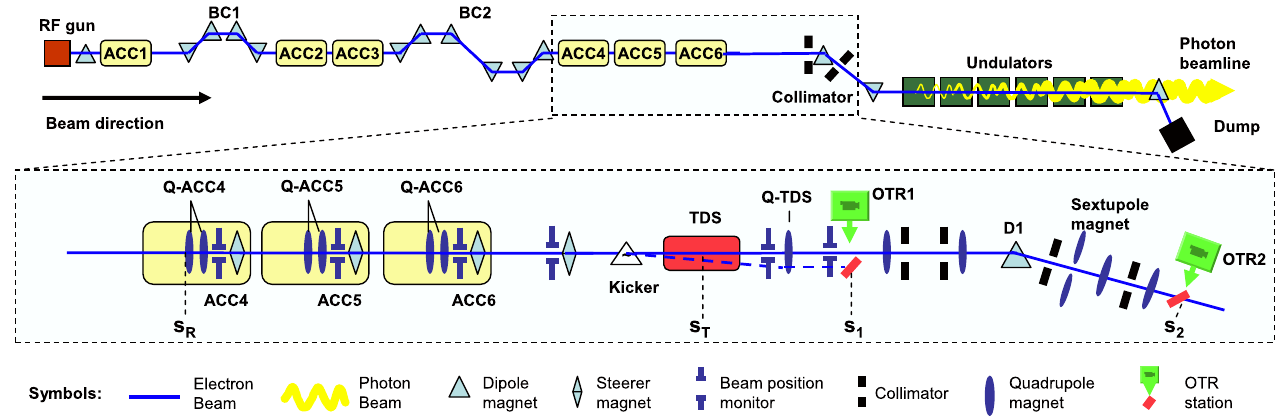
FIG. 1. (Color) Top: Schematic layout of FLASH (not to scale). Bottom: Zoom into the diagnostic beam line comprising the transverse deflecting structure (TDS) and two optical transition radiation stations OTR1 and OTR2. Only a selection of the beam position monitors, steering magnets, and OTR stations installed in this beam line is shown. Also indicated are the longitudinal positions s R (phase space reconstruction point), s T (center of TDS), s (screen OTR1), and s (screen 1 2